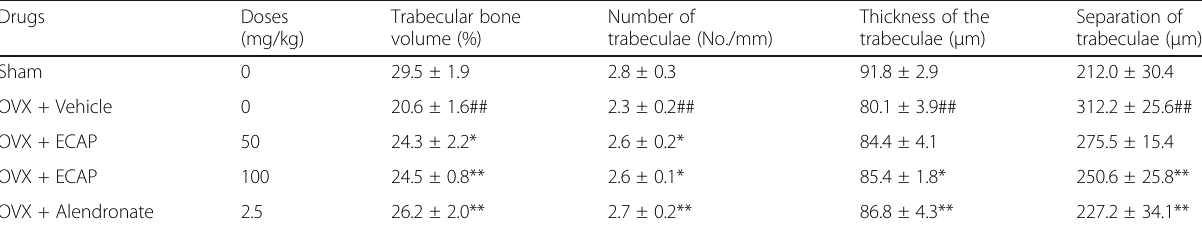
Table 1 Effects of ECAP on the percentage of trabecular bone, number of trabeculae, thickness of the trabeculae and separation of trabeculae of the distal femoral metaphysis in OVX mice by microtomography analysis